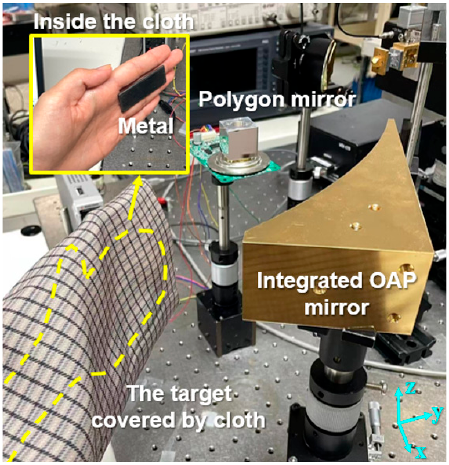
Figure 12. Photograph of the experimental setup for a real imaging experiment.